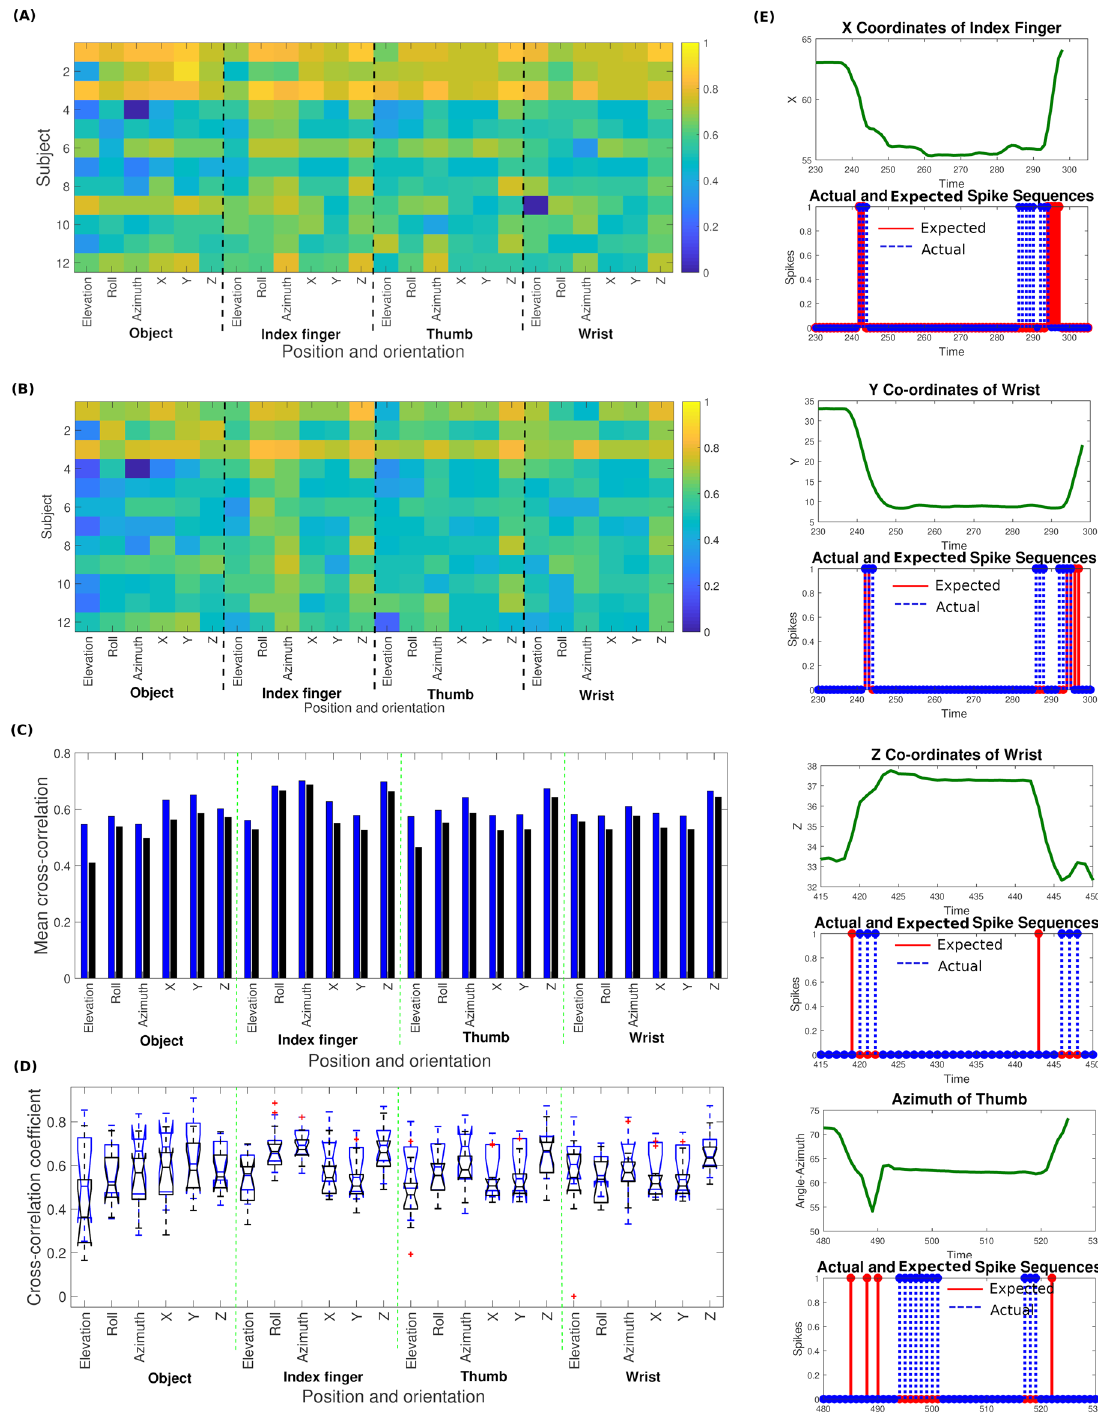
Figure 3. Results of predicting the object and hand kinematics using BI-SNN and GLM approaches. ( A ) The maximum coefficient of the cross-correlation sequence between the actual and predicted kinematic signal by BI-SNN. ( B ) The maximum cross-correlation coefficients between the actual and predicted kinematic signal by GLM. ( C ) Comparison between the BI-SNN and GLM methods on predicting the object and hand kinematics. ( D ) The statistical distribution of the cross-correlation coefficients within the participant group. The correlation analysis shows that the BI-SNN results in a ‘moderate’ to ‘high’ cross-correlation ( 0.6 ≤ r ≤ 0.7 ) in predicting x, y, z Cartesian coordinates. ( E ) The actual kinematic signals and the spike response of a single neuron in SPAN index-x , SPAN wrist-y , SPAN wrist-z and SPAN thumb-azimuth populations during a Grasp-and-Lift